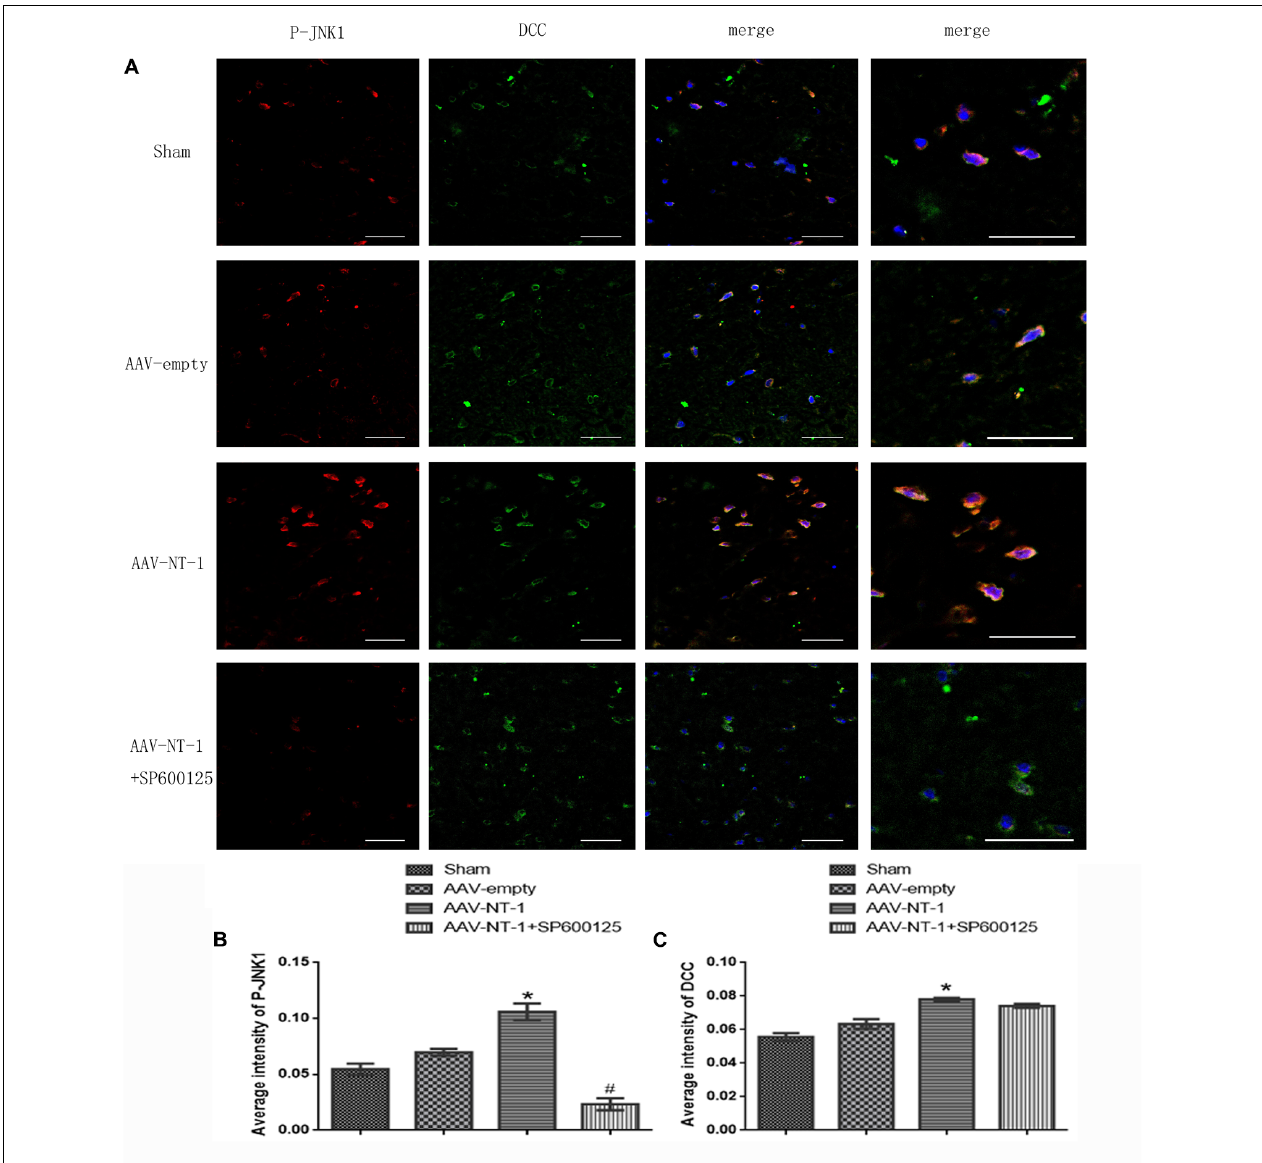
FIGURE 4 | Co-localization of p-JNK1 and DCC. (A) Representative images of each group were shown. Rats in each group were sacrificed at Day 14 after the MCAO. Columns displays the expression of p-JNK1 (red), DCC (green), DAPI (blue); the right column displays the co-localization of p-JNK1, DCC and DAPI. White arrow points at distinct areas of co-localization. Scale bars = 50 µ m. (B) Immunofluorescence analysis of p-JNK1, ∗ p < 0.01, as compared with the AAV-empty group; # p < 0.05, as compared with the AAV-NT-1+SP600125 group. (C) Immunofluorescence analysis of DCC ( n = 3), ∗ p < 0.05, as compared with the AAV-empty group; # p < 0.05, as compared with the AAV-NT-1 group.